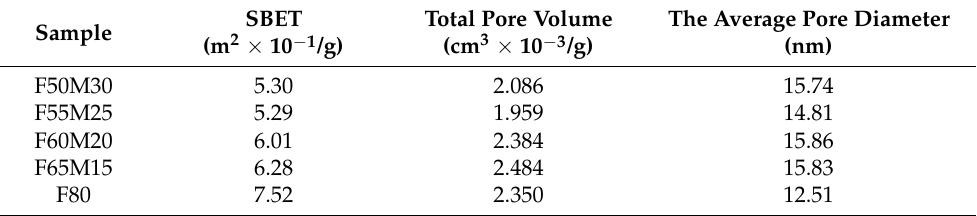
Table 2. Phase composition and surface parameters.